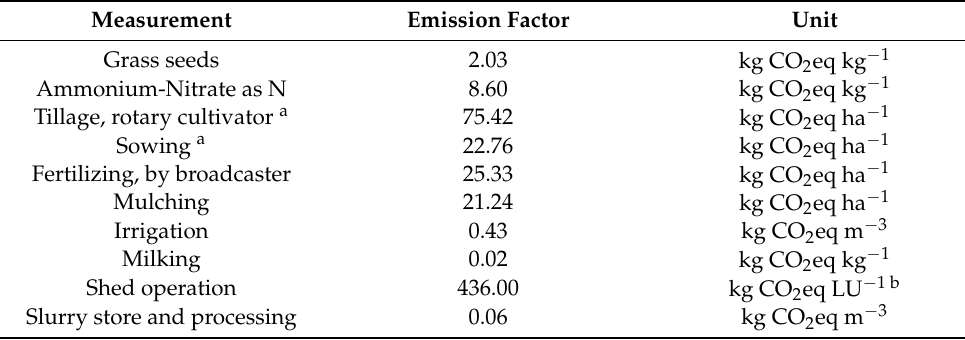
Table 1. Overview of the emission factors used for external resources. Adapted from